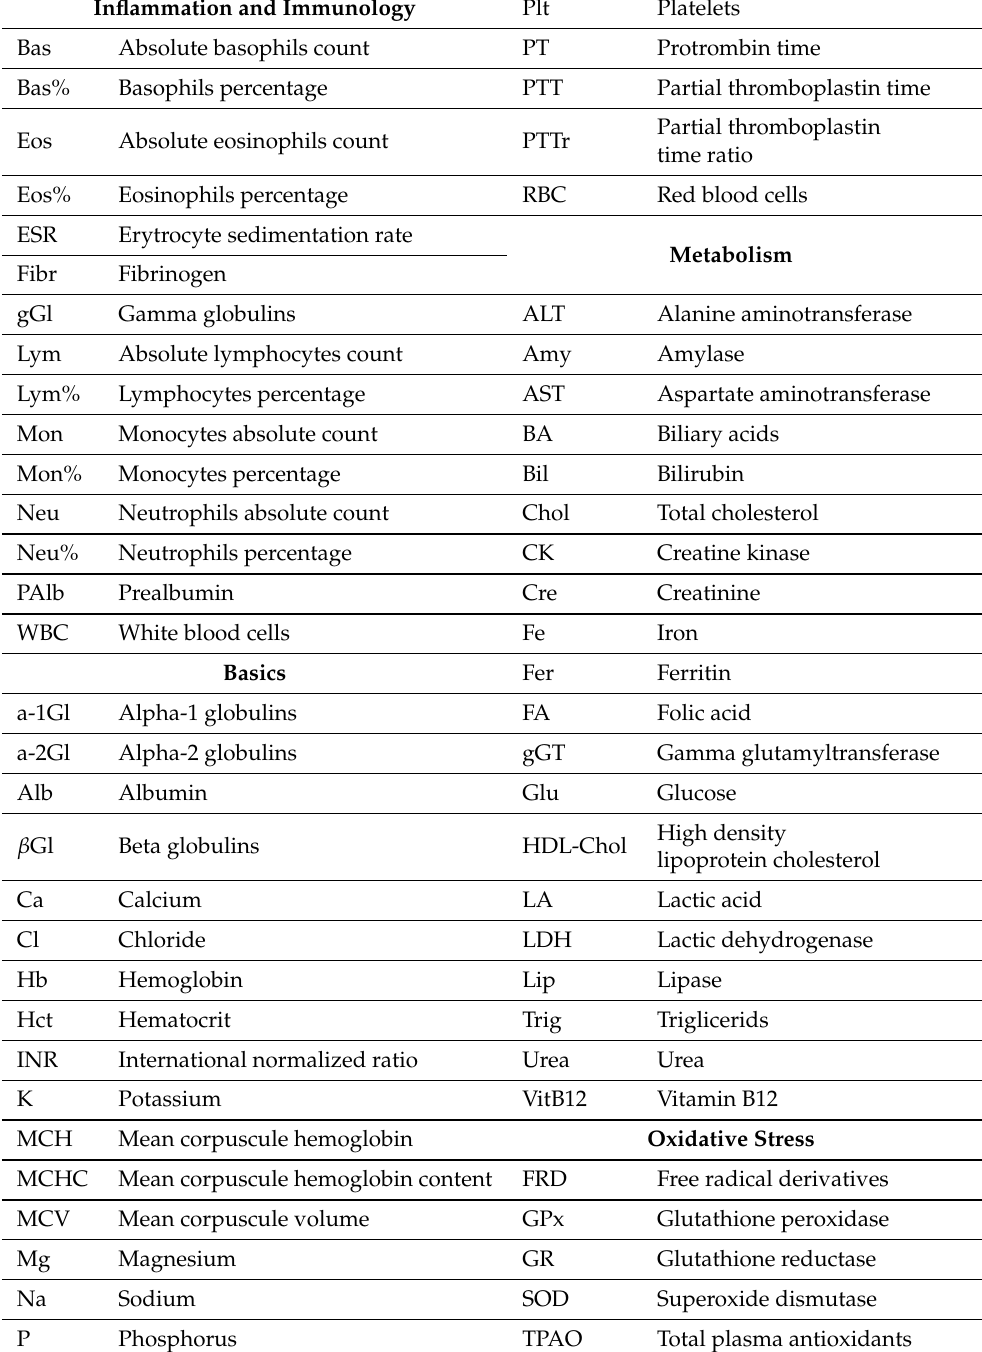
Table 1. List of Analytes used in the